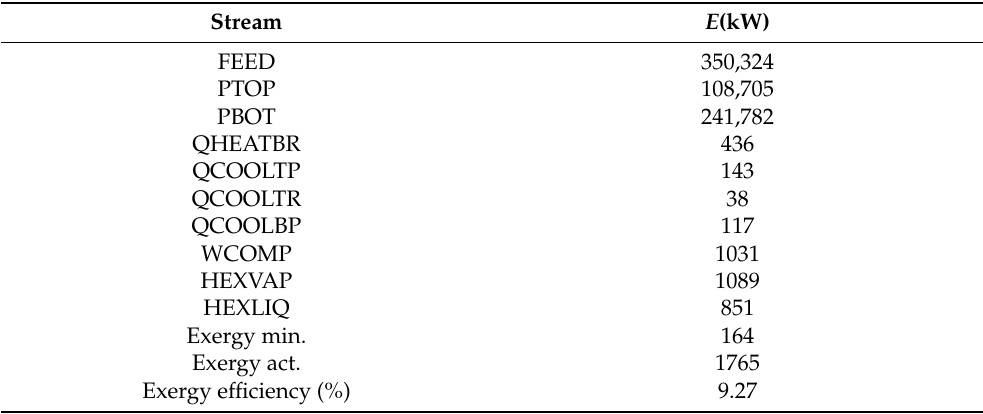
Table 6. Exergy analysis of the conventional VRC system.